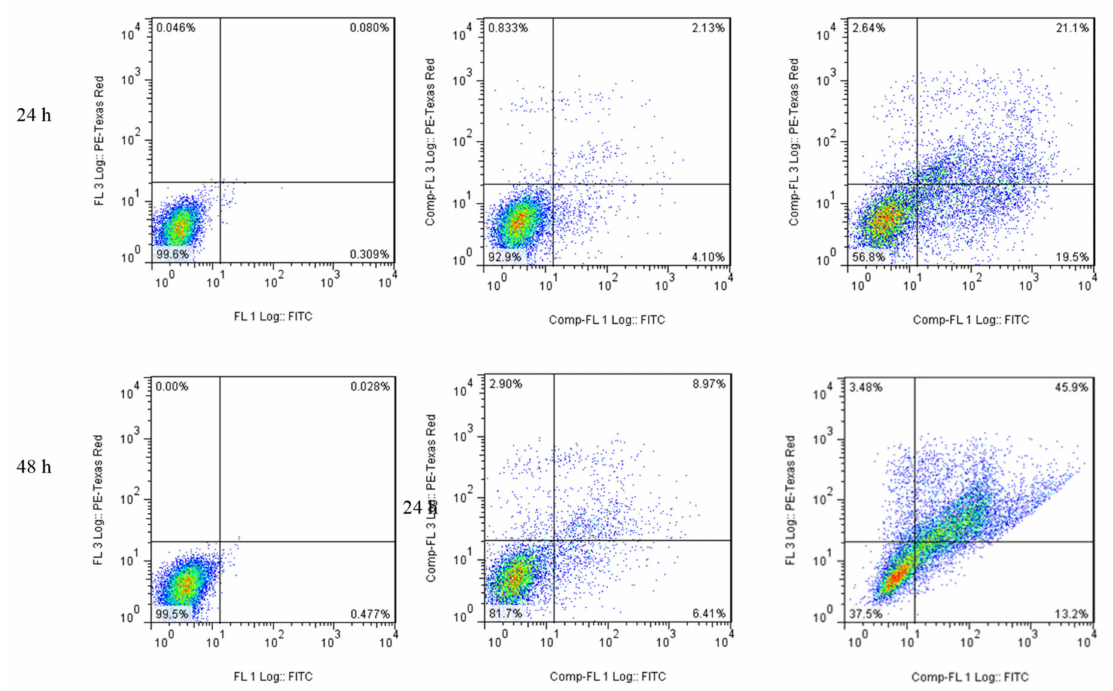
Figure 13. HepG2 cells inoculated with 0 µ M, 5 µ M, or 20 µ M complex 2 for 24 h or 48